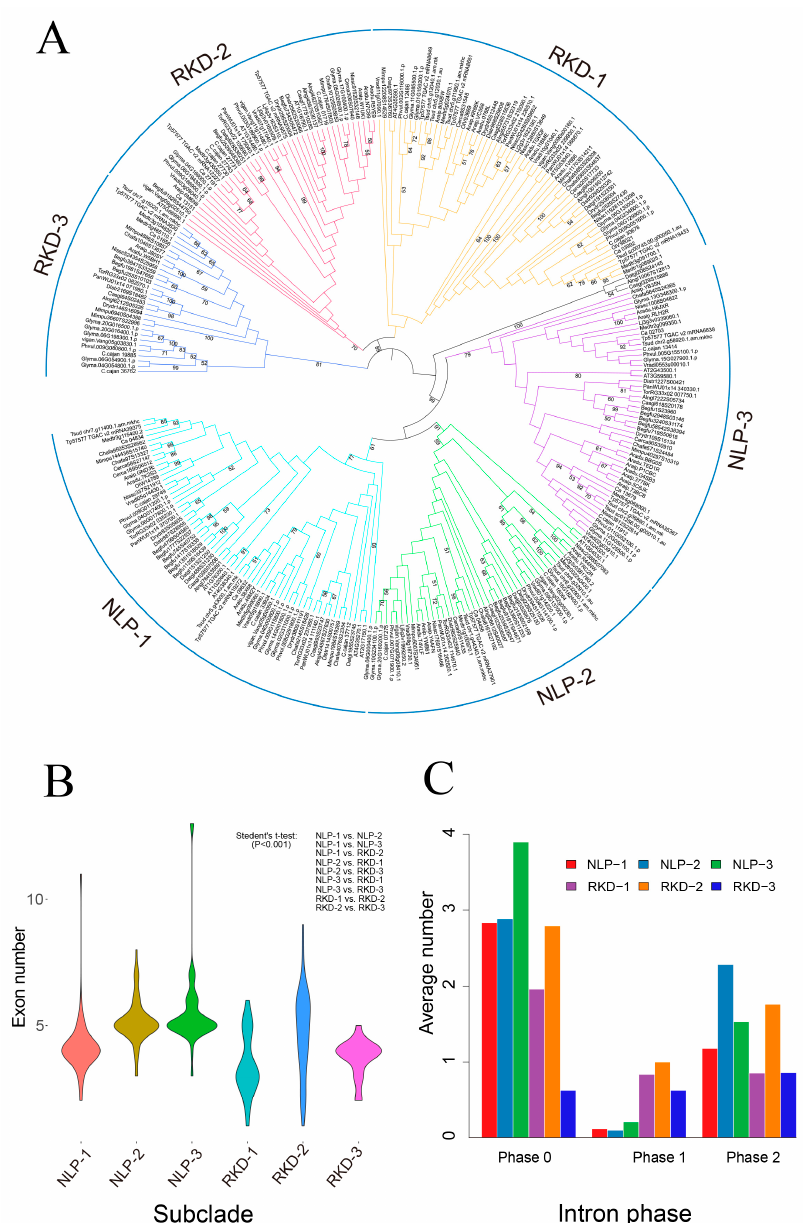
Figure 2. Phylogeny and exon features of RWP-RK proteins. ( A ) Gene tree constructed by the neighbor-joining method with 1000 bootstrap values. The bootstrap values ranging from 50 to 100 were shown on each branch. ( B ) Exon number for each subclade indicated by violin plots. Statistical tests with significance were shown on the top right. ( C ) Average number of exons for six subclades of RWP-RKs with phase 0, phase 1 and phase 2.